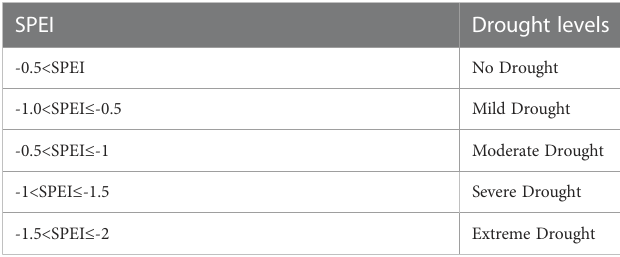
TABLE 1 Drought grade of standardized precipitation evapotranspiration